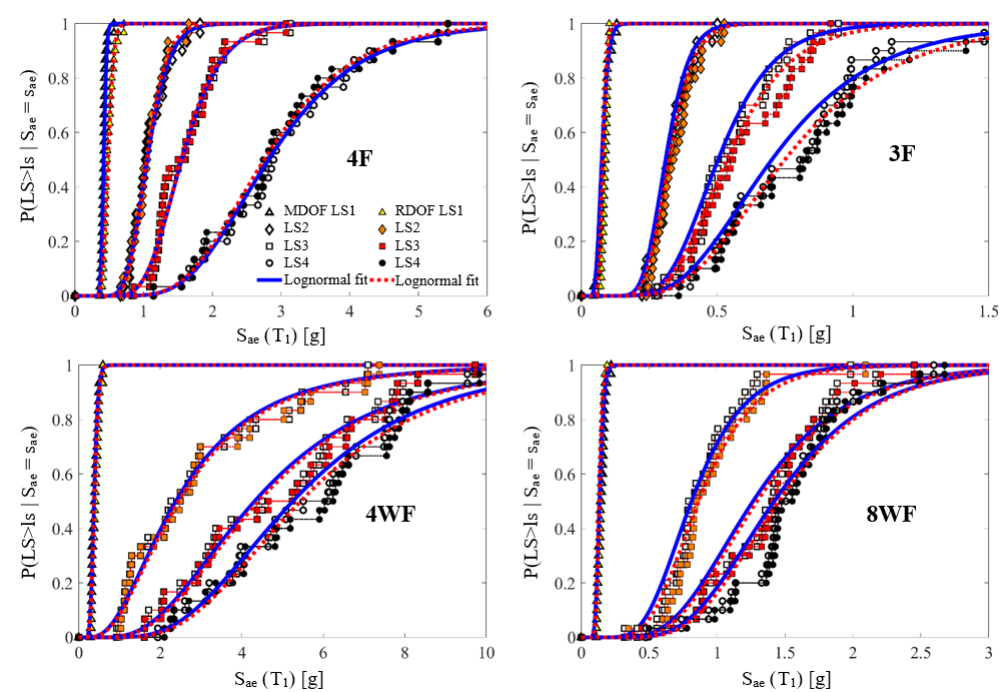
Figure 11. Fragility functions based on lognormal cumulative distribution functions and sample-based (empirical) fragility functions for all limit-states for RDOF and MDOF models of 4F, 3F, 4WF and 8WF buildings.